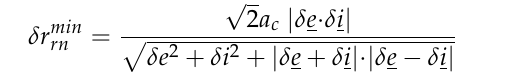
Figure 6. Example of relative eccentricity δ e of two followers 𝑖 = 1,2.